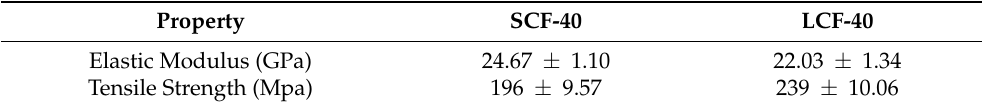
Table 1. Monotonic tensile test results at room temperature for the injection-moulded materials with standard deviation reported as plus minus.